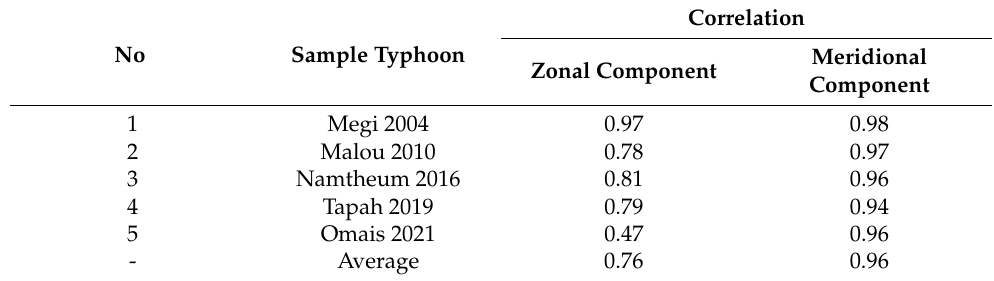
Table 2. Correlation of prediction and actual condition for zonal and meridional components. No Sample Typhoon